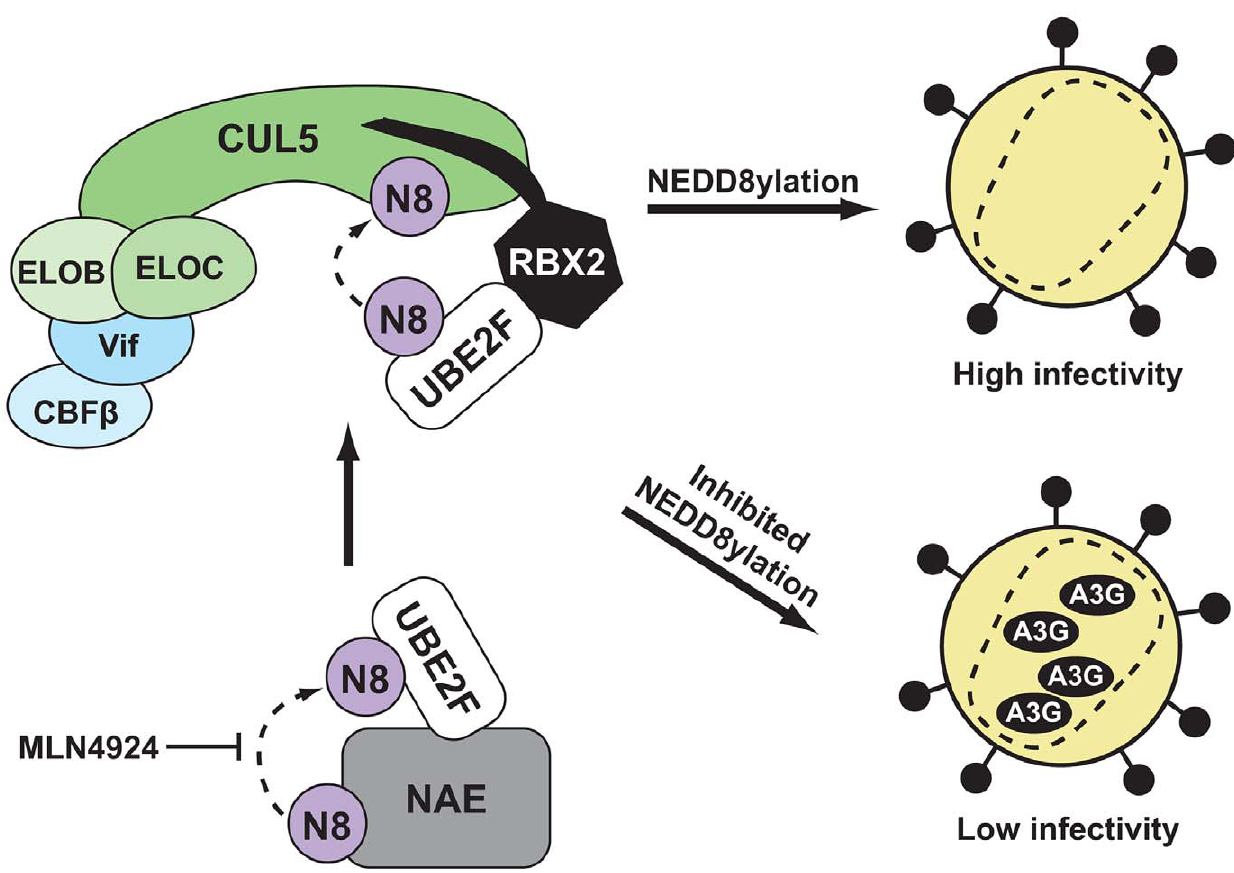
Figure 7. A model illustrating how inhibition of CUL5 NEDD8ylation leads to reduced infectivity of HIV. Two enzymatic steps must take place in order for CRL5 Vif-CBFß to be properly activated by NEDD8 conjugation, and therefore for A3G-degradation to take place, in cells infected with HIV. First, NEDD8 is loaded onto the E2 UBE2F by NAE. The small molecule MLN4924 is able to inhibit this step, blocking degradation of A3G and thereby reducing viral infectivity. Second, UBE2F is recognized by the RBX2 subunit of CRL5 Vif-CBFß , and transfers NEDD8 to CUL5.